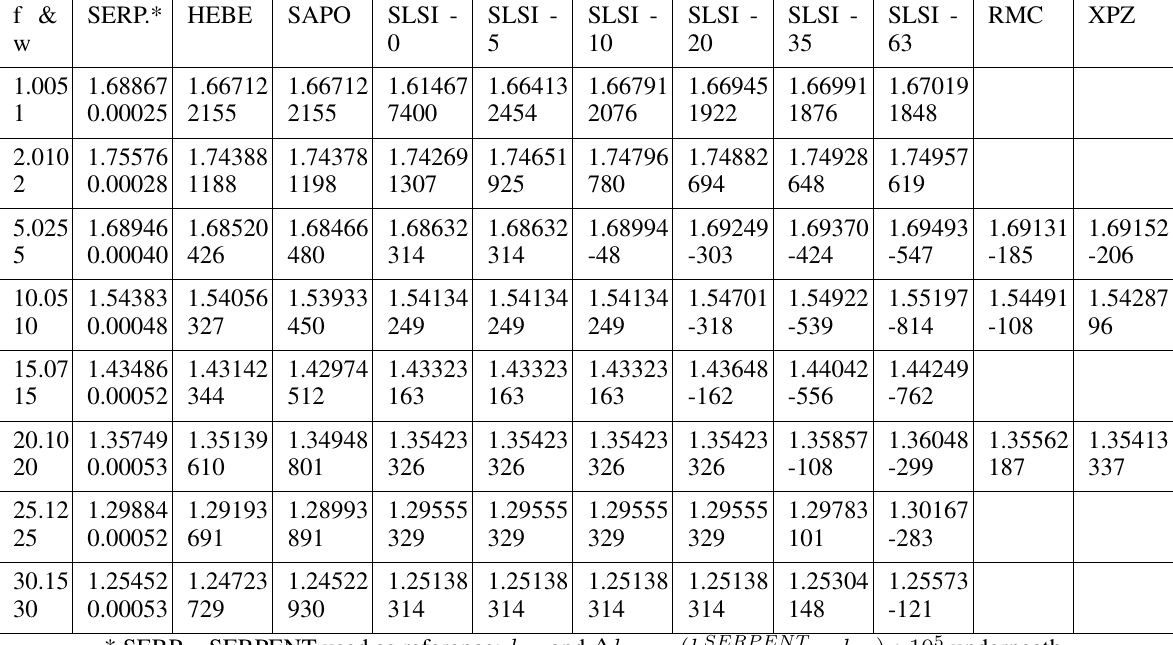
Table 1: k for fuel pebbles with different enrichments and ∞